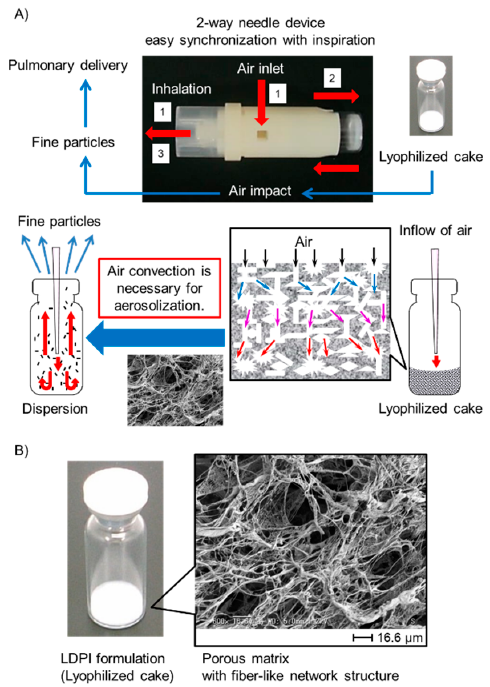
Figure 2. ( A ) Mechanism of lyophilizate for dry powder inhalation (LDPI) system. (1) Air is introduced into the vial in synchronization with the patient’s inhalation through the two-way needle device. (2) Lyophilizate with a porous matrix structure is broken into pieces by air impact and aerosolized by the convection flow of air in the vial. (3) Porous particles reconstructed from pieces of lyophilizate are emitted through the device. ( B ) Enlarged picture of LDPI formulation and scanning electron microscope image. LDPI formulation is a lyophilized cake having porous matrix with fiber-like network structure.